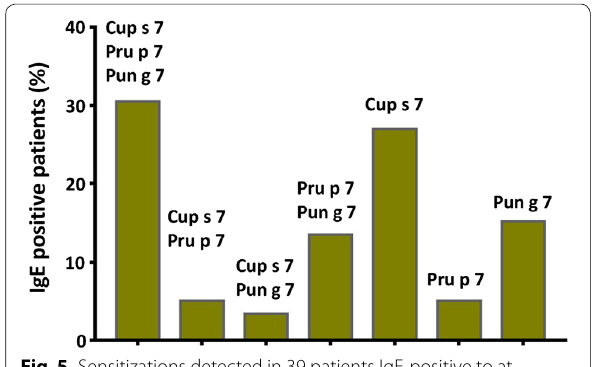
Fig. 5 Sensitizations detected in 39 patients IgE-positive to at least one of the three analyzed GRP. The columns indicate, in order, patients sensitized to all the three GRP, those bi-sensitized to Cup s 7 and Pru p 3, to Cup s 7 and Pun g 7, to Pru p 7 and Pun g 7 and those monosensitized to Cup s 7, to Pru p 7 and to Pun g